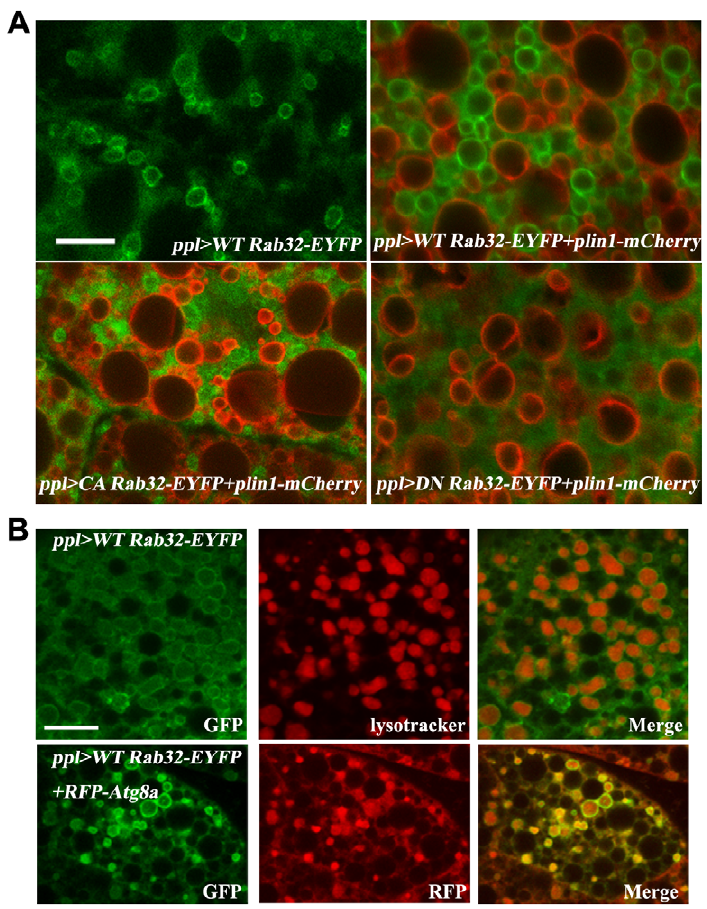
Figure 5. Rab32 is localized to the lysosome and autophagosome. (A) The localization of WT, CA- and DN-Rab32-EYFP in wandering stage third instar larval fat body cells. WT and CA-Rab32-EYFP are localized to ring-like structures and do not colocalize with the lipid droplet marker PLIN1- mCherry. DN-Rab32-EYFP is located in the cytosol. Scale bar: 20 m m. (B) WT Rab32-EYFP appears as rings surrounding lysotracker-labeled lysosomes and RFP-Atg-8-marked autophagosomes. Scale bar: 20 m m.